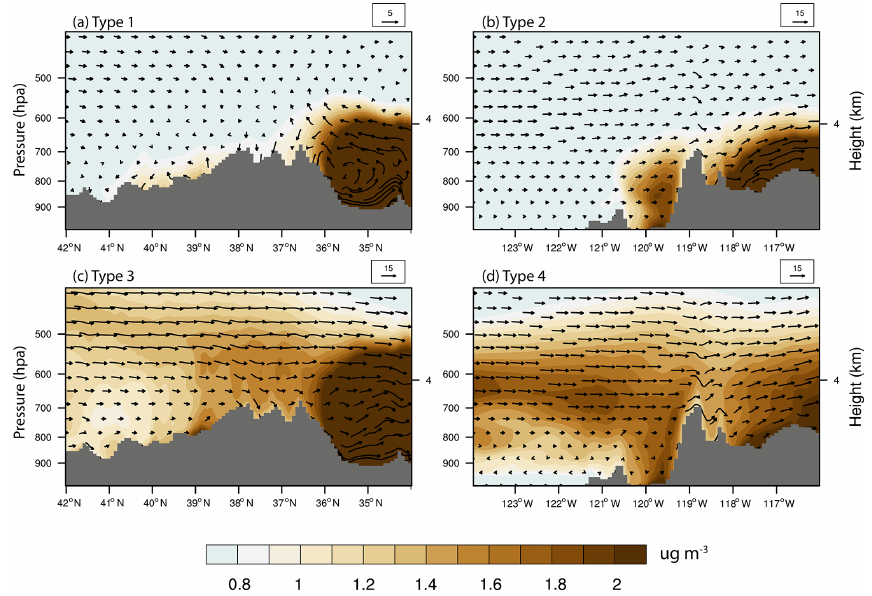
Figure 5. Cross-section of dust concentration (shaded; ugm − 3 ) and dust transport fluxes (vectors; µm − 2 s − 1 ) at 1000–400hPa for each SOM type in WRF-Chem. The position of each cross-section is denoted in Fig. 3b (type 1), d (type 2), f (type 3), and h (type 4). The grey area indicates the topography of the Sierra Nevada.